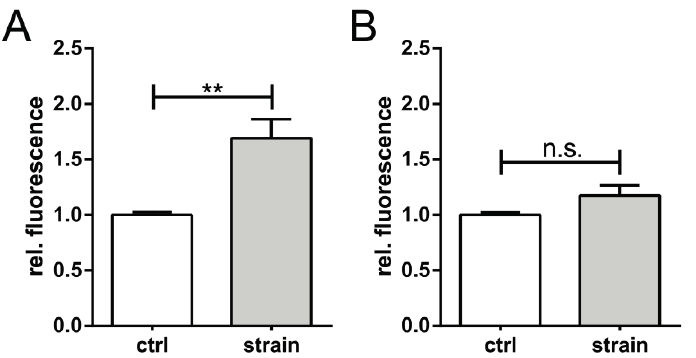
Figure 3. Stretch-mediated activation of VEGF promoter activity. Dual luciferase reporter assays were used to screen VEGF promoter activation upon stretching. C-28/I2 chondrocytes were transfected with a VEGF-promoter specific reporter construct (pVEGF-KpnI), expressing inducible Firefly luciferase, and a constitutive active Renilla luciferase for normalization purposes. Cells were stretched (8%, 0.5 Hz, 12 h square waveforms ( A ) and the ratio of Firefly-to- Renilla signals is shown. The unstrained control (ctrl) is set to 100% ( i.e. , 1); HRE activity ( B ) was measured using a Hypoxia Responsive Element (HRE) reporter construct (pGL3-HRE). Unstrained controls (ctrl), stretched cells (strain). ** indicates p ≤ 0.01, n.s. = not significant; n =